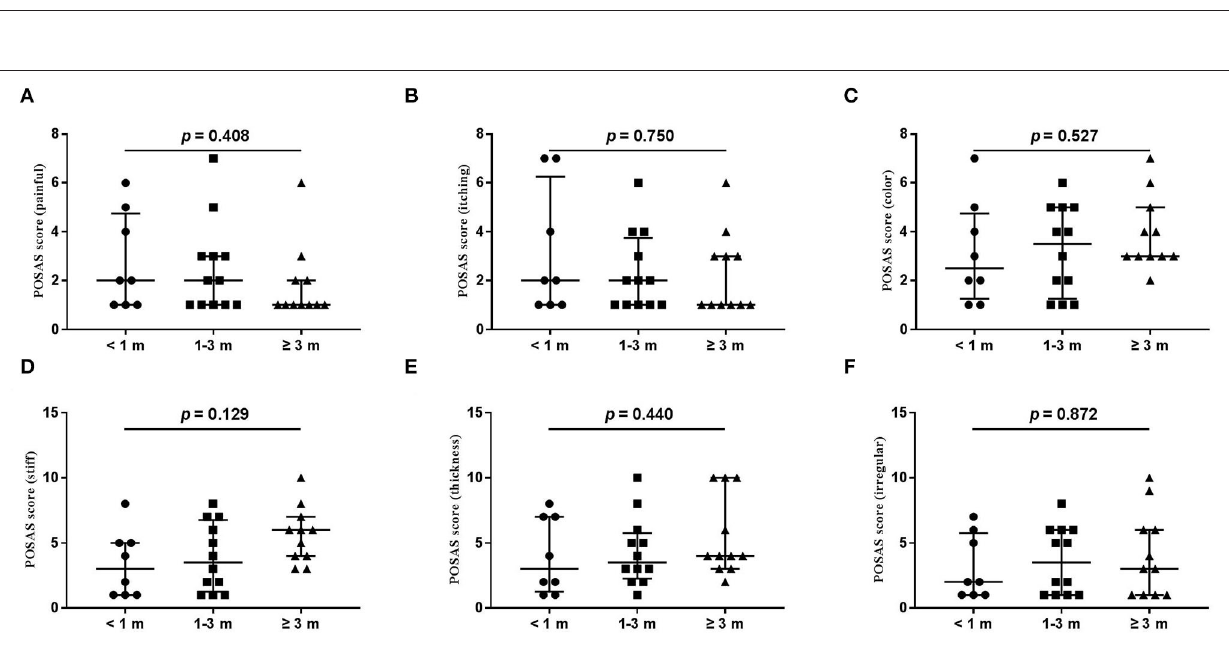
FIGURE 4 | Each item of the POSAS patient scale. (A) painful; (B) itching; (C) color; (D) stiff; (E) thickness; (F) irregular. The numbers of patients in groups of < 1 month, 1–3 months, and ≥ 3 months were 8, 11, and 12,